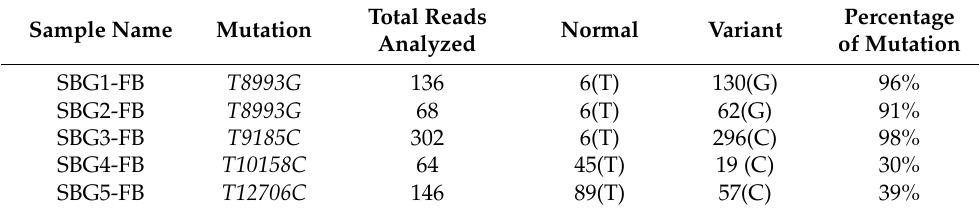
Table 2. Quantification of heteroplasmy by next-generation sequencing. The extracted mtDNA was sequenced using whole-exome sequencing methods. The sequencing results were compiled and analyzed as detailed in the methods section. This allows us to compute heteroplasmic variants based on the sequencing reads. Results demonstrate the presence of pathogenic mtDNA burden in all LS fibroblast